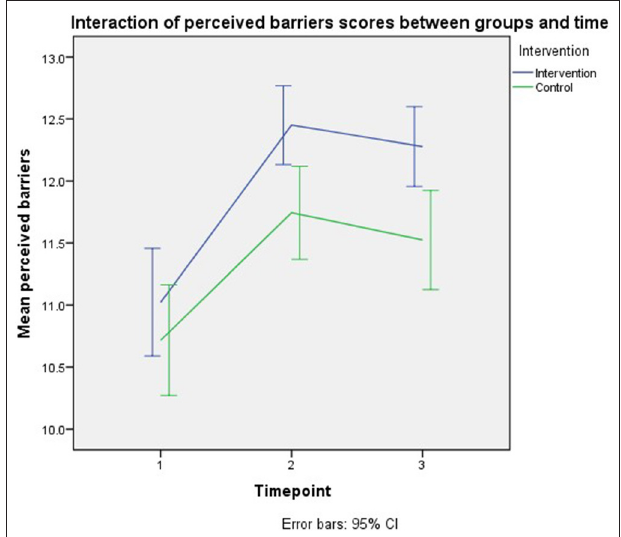
FIGURE 6 | Interaction of perceived barriers scores between groups and time.